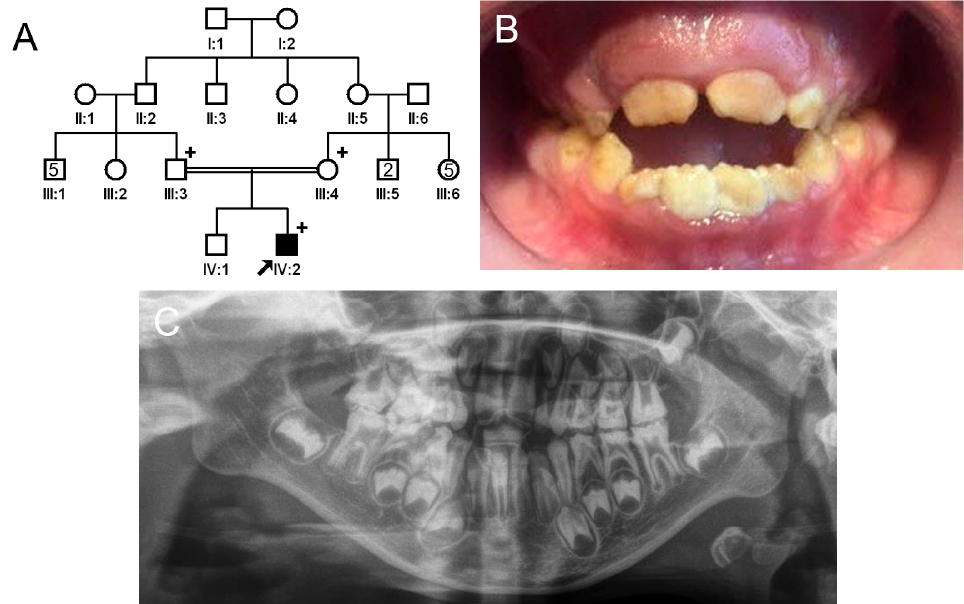
Figure 3. Pedigree, clinical photo, and panoramic radiograph of family 2. ( A ) Pedigree of family 2. The black symbol indicates the affected individual, and the proband is indicated by a black arrow. A plus sign above the symbol indicates participating individuals. ( B ) Clinical photo of the proband at age 7 years. He has an anterior open bite with a constricted maxilla. ( C ) Panoramic radiograph of the proband at age 7 shows enamel fractures and attrition in almost all posterior teeth including first molars. The affected enamel has reduced radiopacity, making it similar to the underlying den- tin.